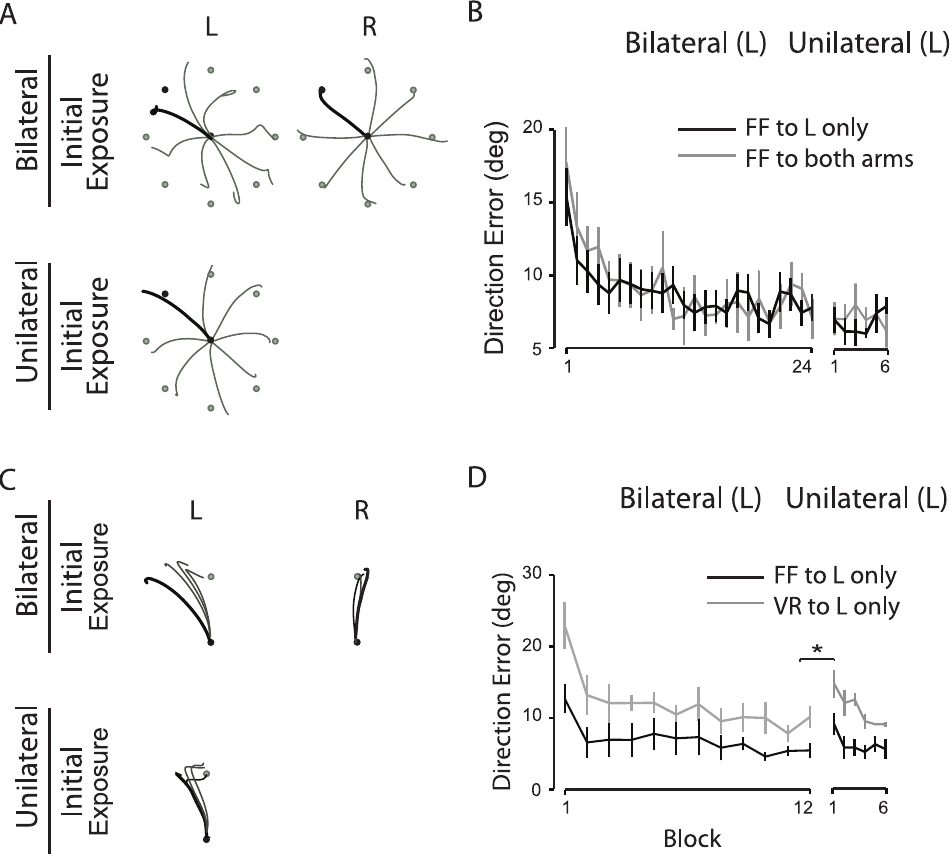
Figure 3. Reaching performance observed when the sensorimotor perturbation was only provided to the left arm. A, Hand-paths from a representative subject who experienced the force field provided only to the left arm during both the bilateral and unilateral sessions. B, Mean direction errors. Every data point shown on X axis represents the average of 8 consecutive trials (cycle) across subjects (mean 6 SE) when the force field was provided only to the left arm (FF to L only, black lines) or to both arms (FF to both arms, grey lines). C, Hand-paths from a representative subject who experienced the force field provided only to the left arm during both the bilateral and unilateral sessions and reached toward a single target. D, Mean direction errors. Every data point shown on X axis represents the average of 8 consecutive trials (block) across subjects (mean 6 SE) in the dynamic task condition (FF to L only, black lines) or in the visuomotor task condition (VR to L only, grey lines). * P , .05.